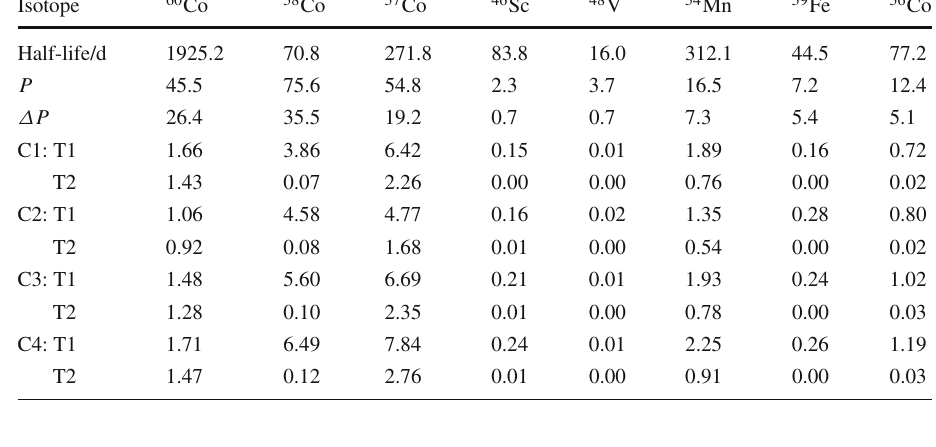
Table 5 Activities A (unit: decays kg − 1 d − 1 ) of relevant cosmogenic radioisotopes in Cu used for the Conus Ge detector cryostats for the points in time T1 and T2. The prediction is based on known activation and ‘cooling down’ periods during detector manufacturing, on the reported half-lives and sea-level production rates P (unit: atoms kg − 1 d − 1 ) that were averaged from Refs. [43,44,52]. Several standard deviations Δ P are once again large.